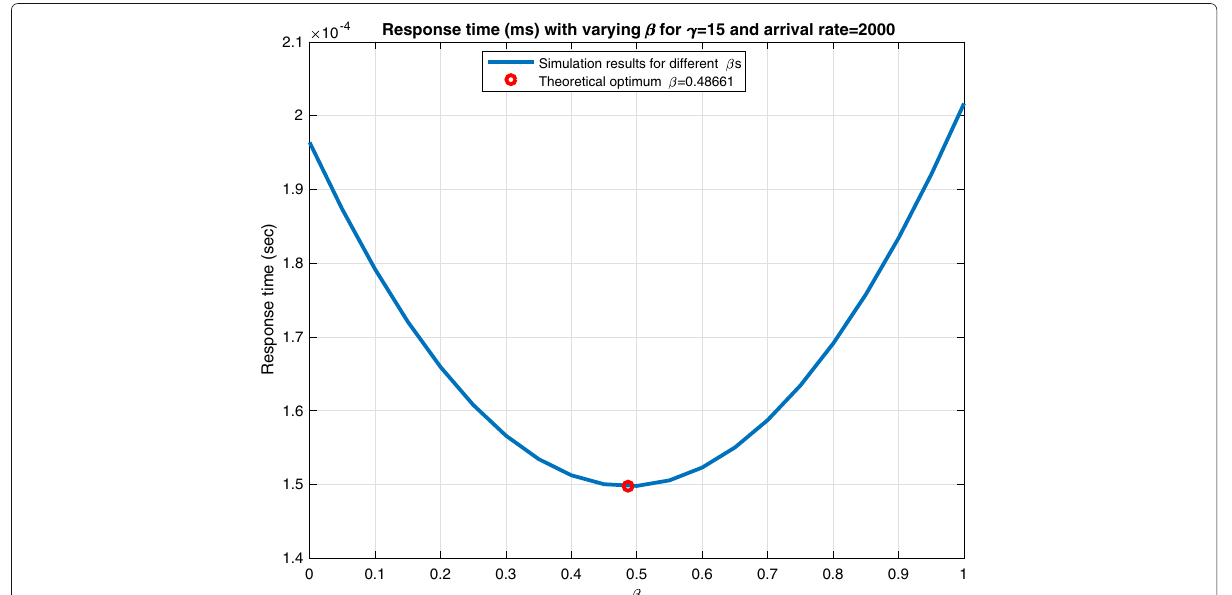
Fig. 10 β vs. Response time (sec) with for γ = 15, and arrival rate=2000. Simulation results for different β , Theoretical optimum β = 0.48661,